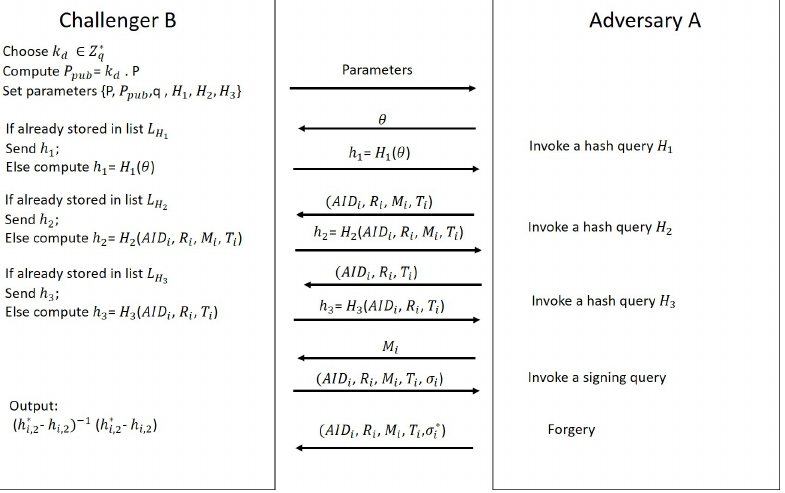
Figure 3. Example of the game played between a challenger B and an adversary A